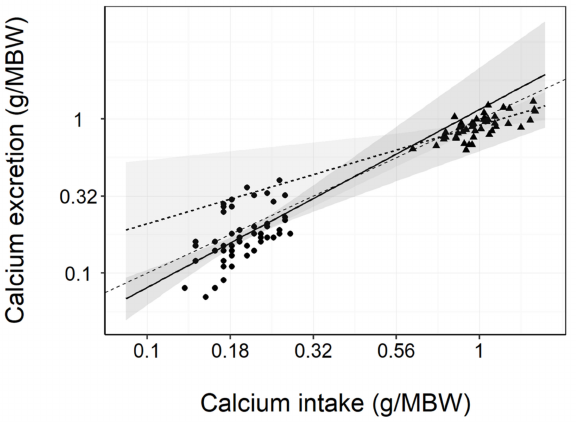
Figure 1. Linear regression between dietary calcium (Ca) intake and fecal Ca excretion (g/kg bodyweight (BW) 0.75 ; metabolic bodyweight (MBW)). The 95% confidence regions for both diet groups surround the y = x (——-) equivalence line. The control ( n = 56; — • —) and test ( n = 50; — (cid:78) —) display as distinct clusters supporting the view that Ca excretion is in proportion to dietary Ca